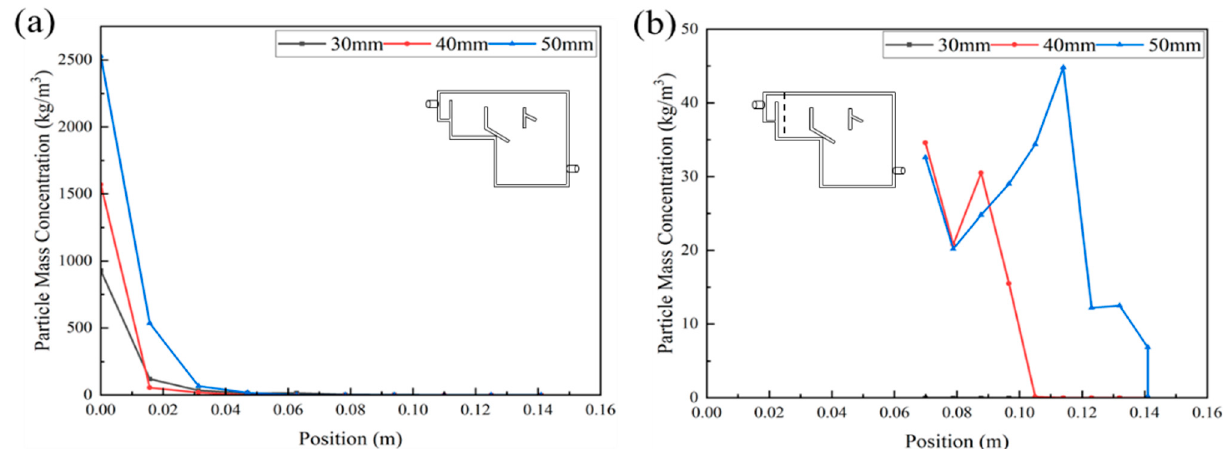
Figure 6. The change in particles’ mass concentration in the vertical direction of the pre-sedimentation zone ( a ) and secondary settling zone ( b ) of the reactor with different baffle distances.